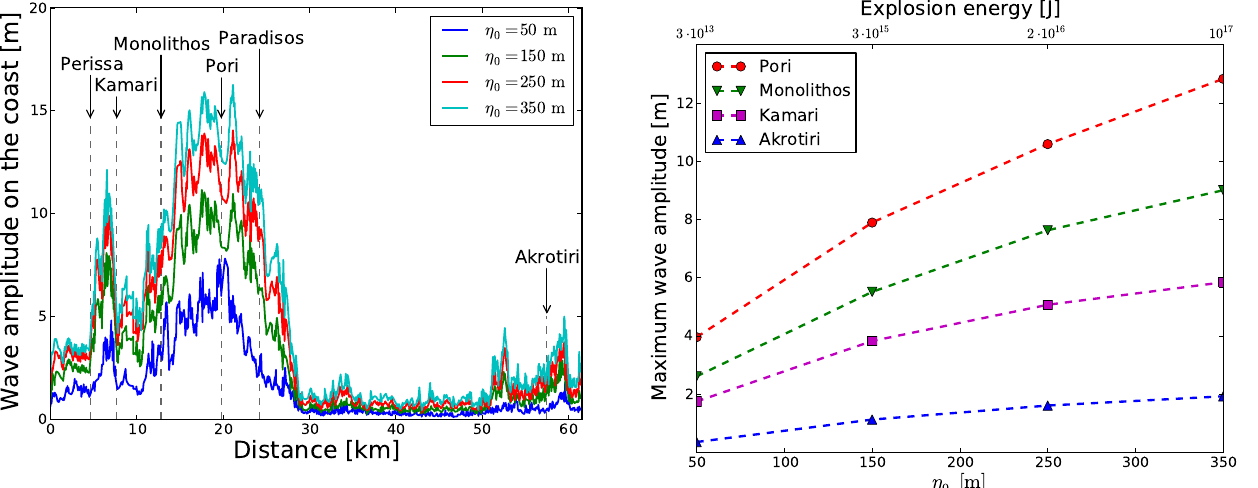
Fig. 10. Flow depth along the original coastline of the main San- torini island for several η 0 . Distance zero corresponds to the south- ernmost point of the island and increases anticlockwise. Distance of the six main coastal towns is depicted by vertical arrows and dashed lines (cf. Fig. 2 for their locations).